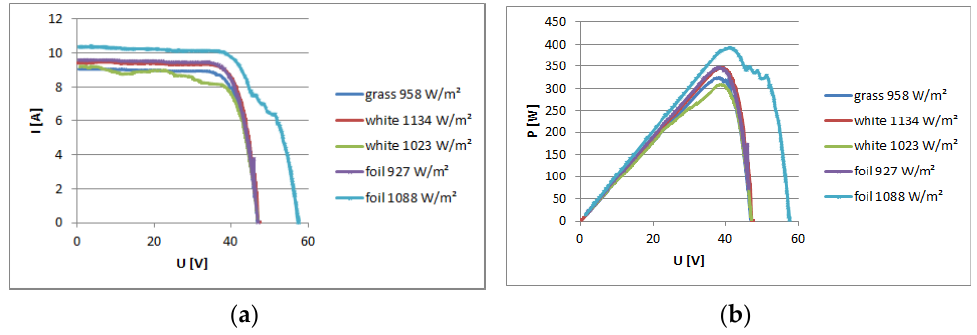
Figure 11. Comparative characteristics of the bifacial module set at an angle of 75° using different substrates: ( a ) current-voltage characteristics; ( b ) power-voltage characteristics. Table 10. The measurements results and calculations for 75° inclination of the module mounted over different substrates.